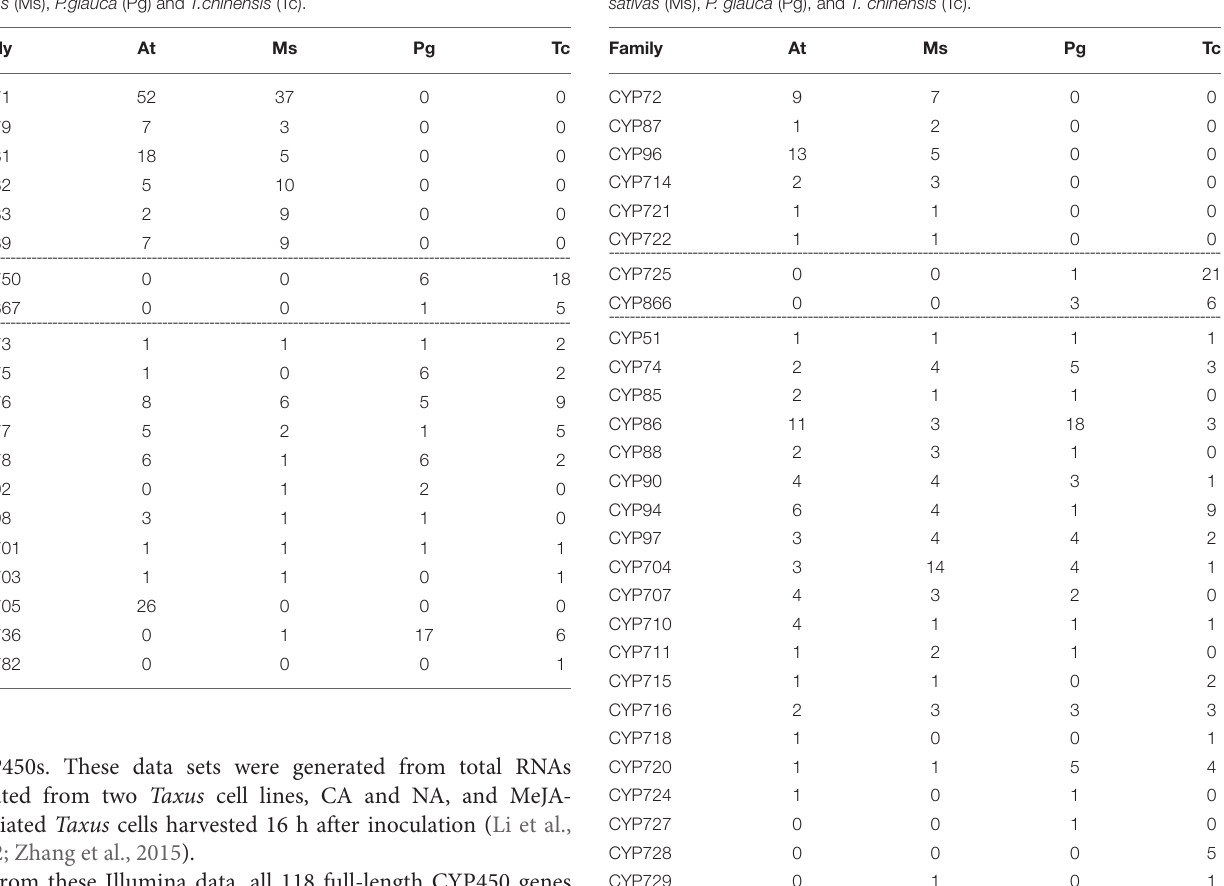
TABLE 3 | Comparison of A-type CYP450 families among A. thaliana (At), M. sativas (Ms), P.glauca (Pg) and T.chinensis (Tc).